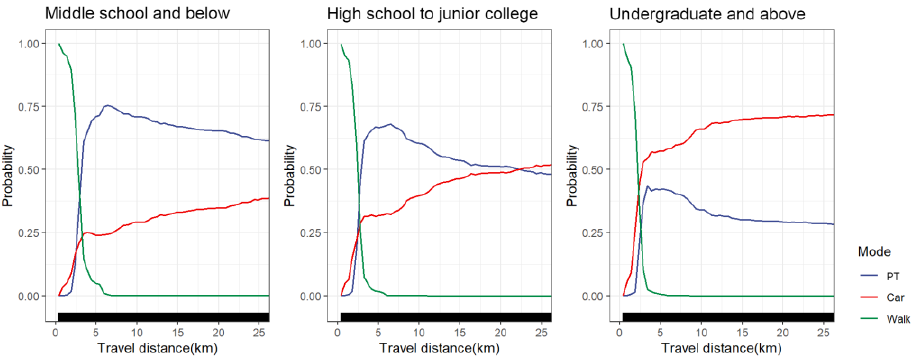
Figure 12. PDP plot of educational level groups differences.